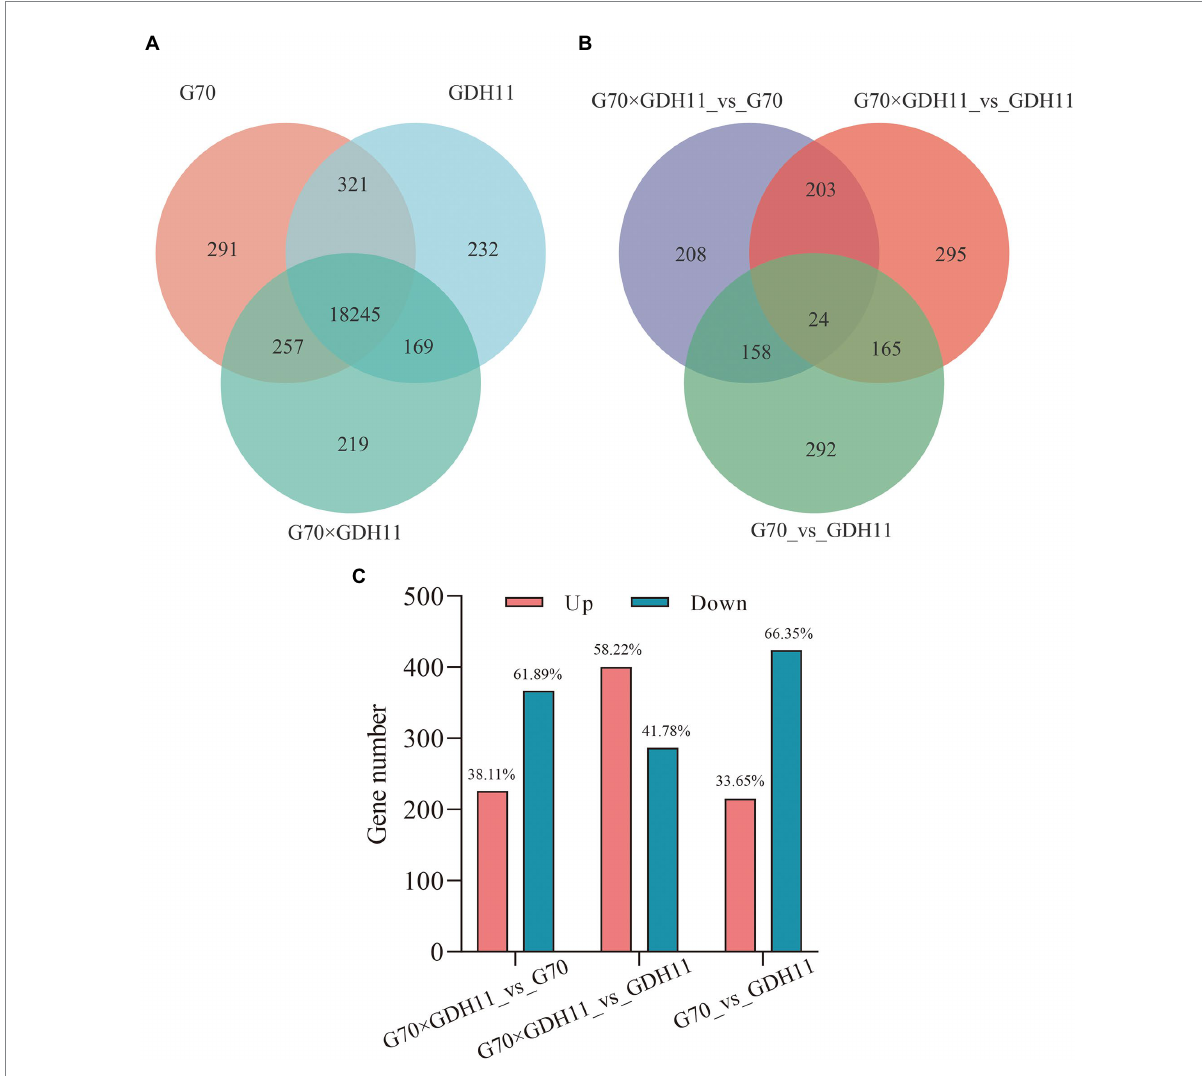
FIGURE 3 The transcriptional profiling statistics of different materials and comparison groups. (A) Venn diagram of the identified genes for the three tobacco varieties. (B) Venn diagram of the DEGs in the comparison groups G70_vs_GDH11, G70 × GDH11_vs_G70, and G70 × GDH11_vs_GDH11. (C) Statistics of up and down regulated differentiallyexpressed genes between hybrid and parental